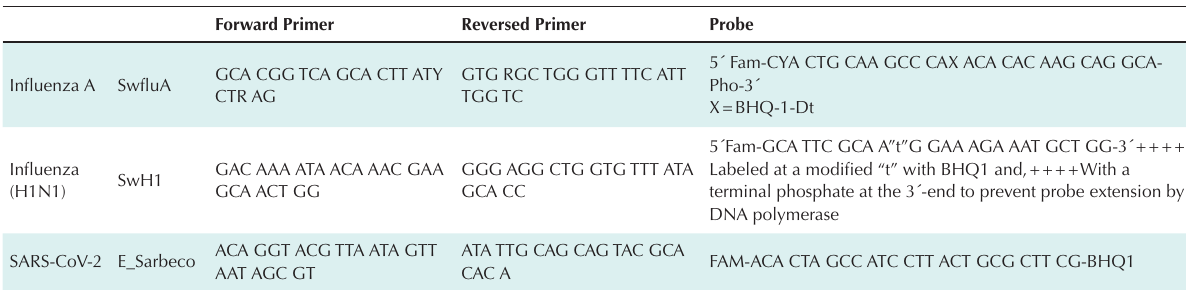
Table 1. Primers and Probes Used for RT-PCR test of InfA, InfB, and SARS-CoV-2 Forward Primer Reversed Primer